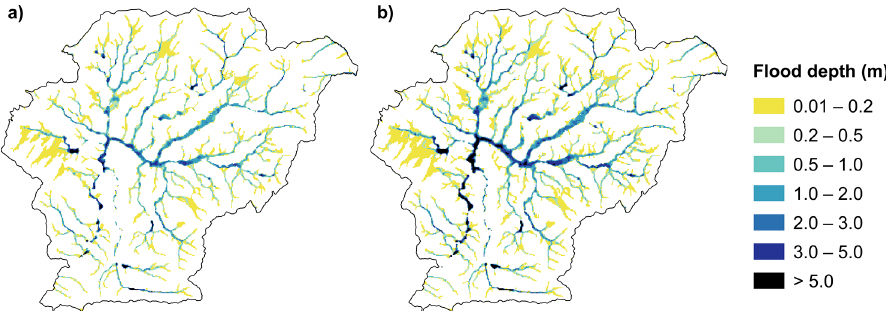
Figure 4. Fluvial–pluvial flood maps for (a) 100-year mean return period and (b) 1000-year mean return period flooding occurrences. The individual flood maps are available online through the METEOR project